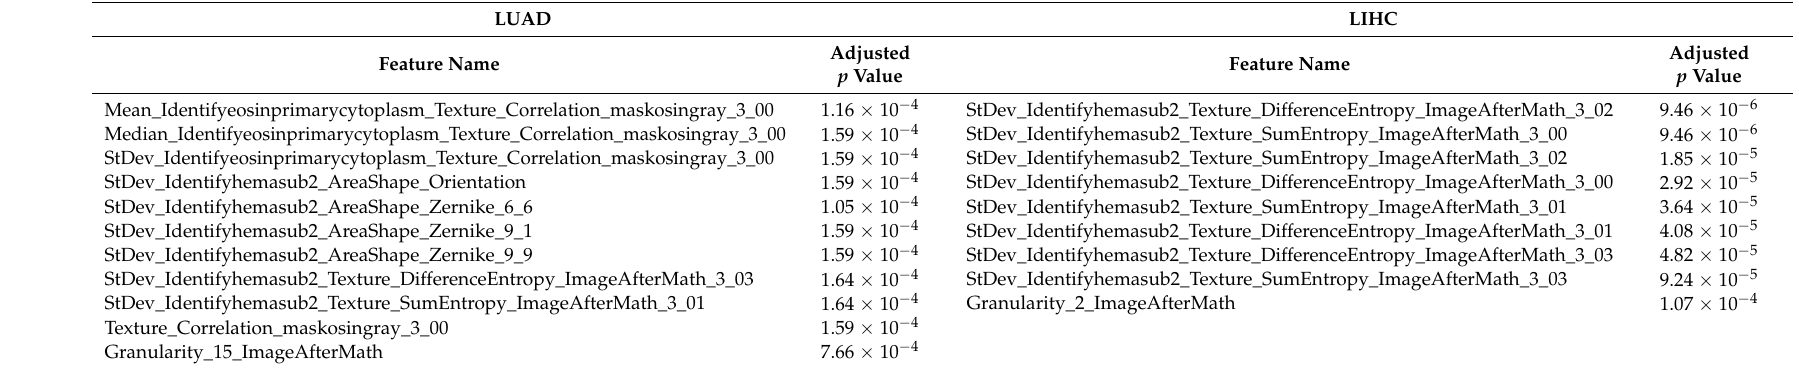
Table 4. Identified histopathological